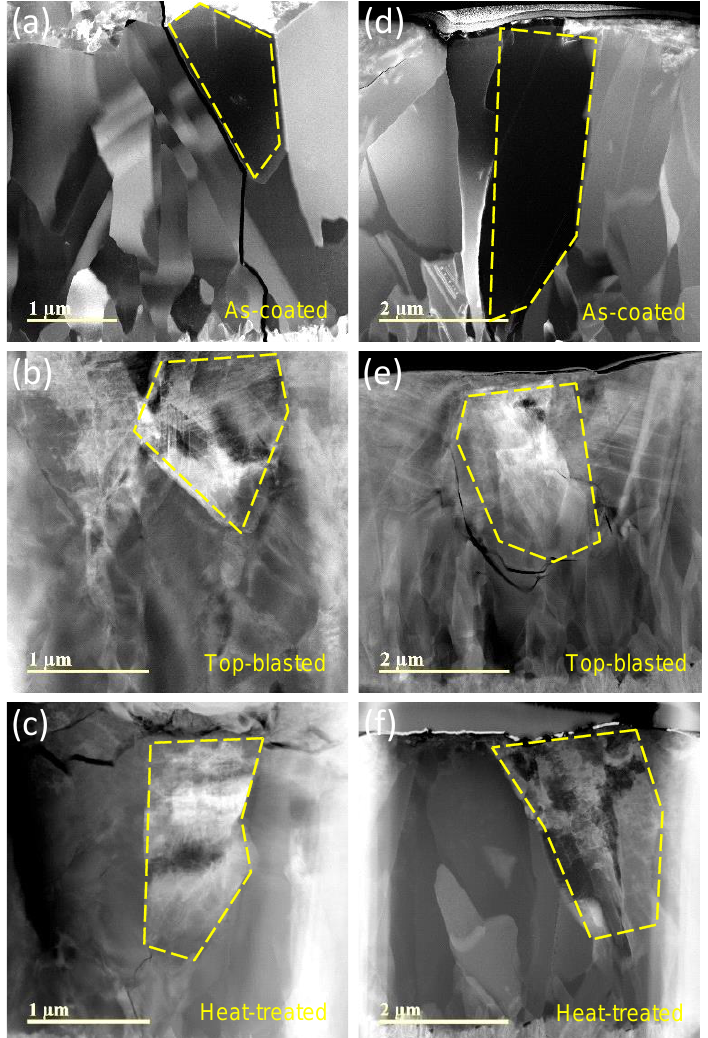
Figure 6. Dark-field STEM images of α-Al 2 O 3 grains in the α-Al 2 O 3 /Ti(C, N) ( a – c ) and α-Al 2 O 3 /Zr(C, N) ( d – f ) samples in different conditions, acquired with one of the grains (marked by the yellow polygons) tilted to a zone axis. The growth direction is towards the top of the images. It can be seen that defects introduced by blasting decreases after annealing.